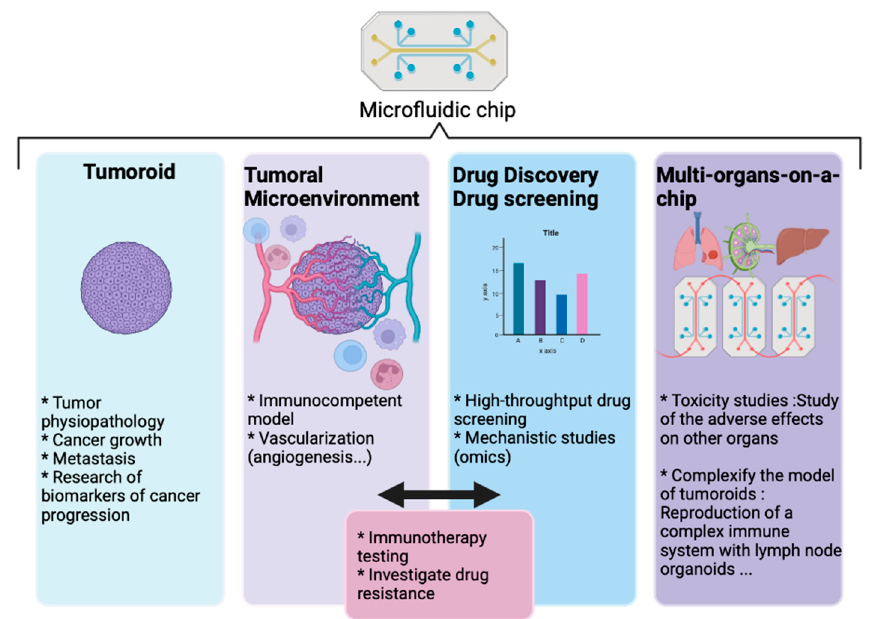
Figure 5. Integrative microfluidics. A combination of tumoroid and microfluidic technologies into a chip format provides access to more relevant, and multipurpose models. Created with BioRen- der.com.